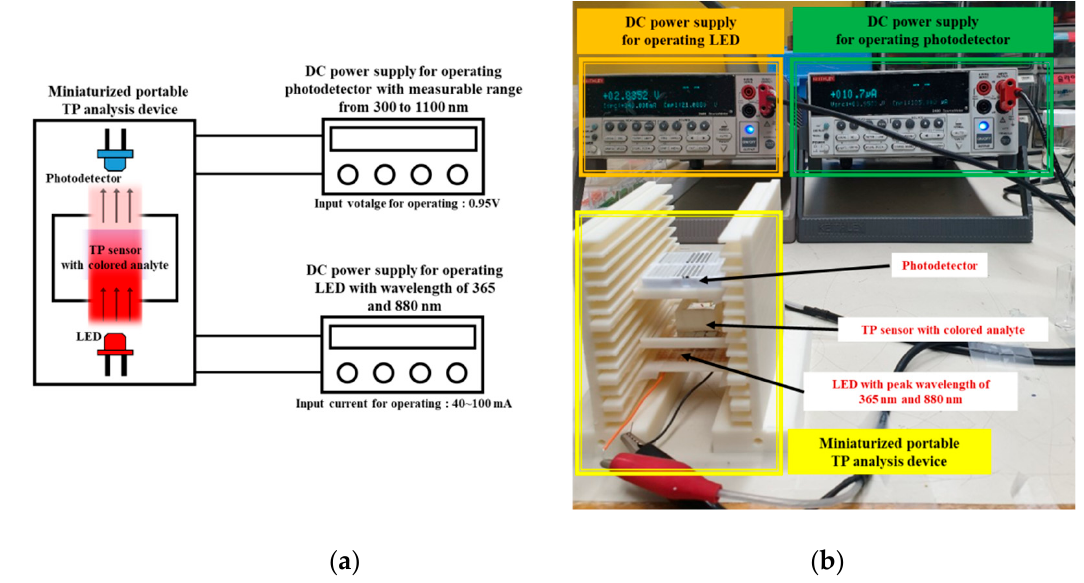
Figure 8. ( a ) Schematic diagram of the experimental setup for assessing the miniaturized TP analysis device and ( b ) picture of the experimental setup.